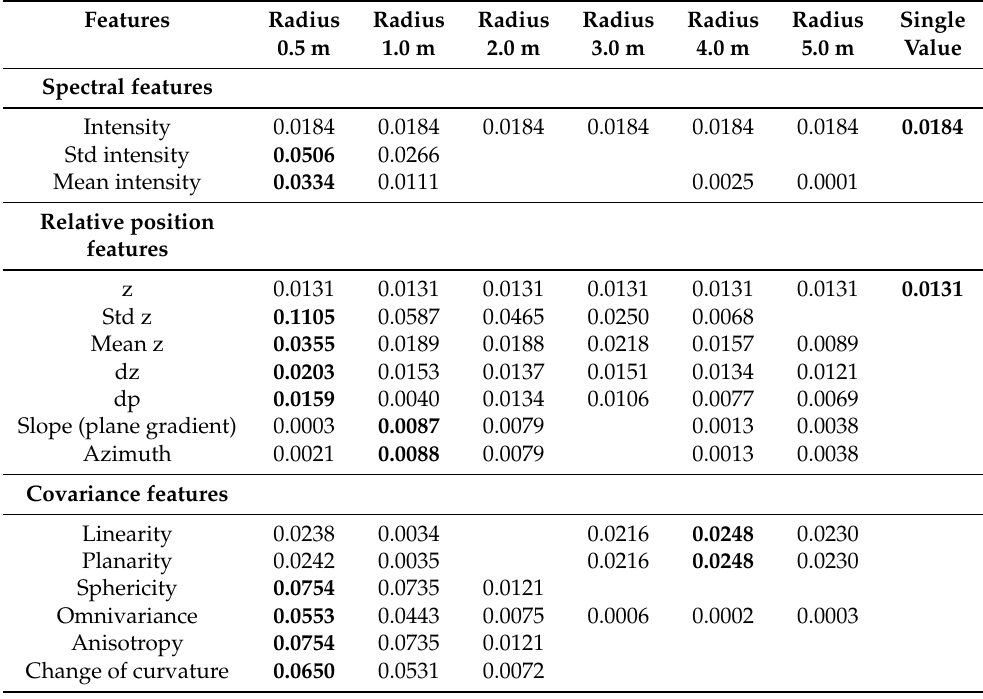
Table 4. Boulder 2 predictors with positive weight calculated from relief-F